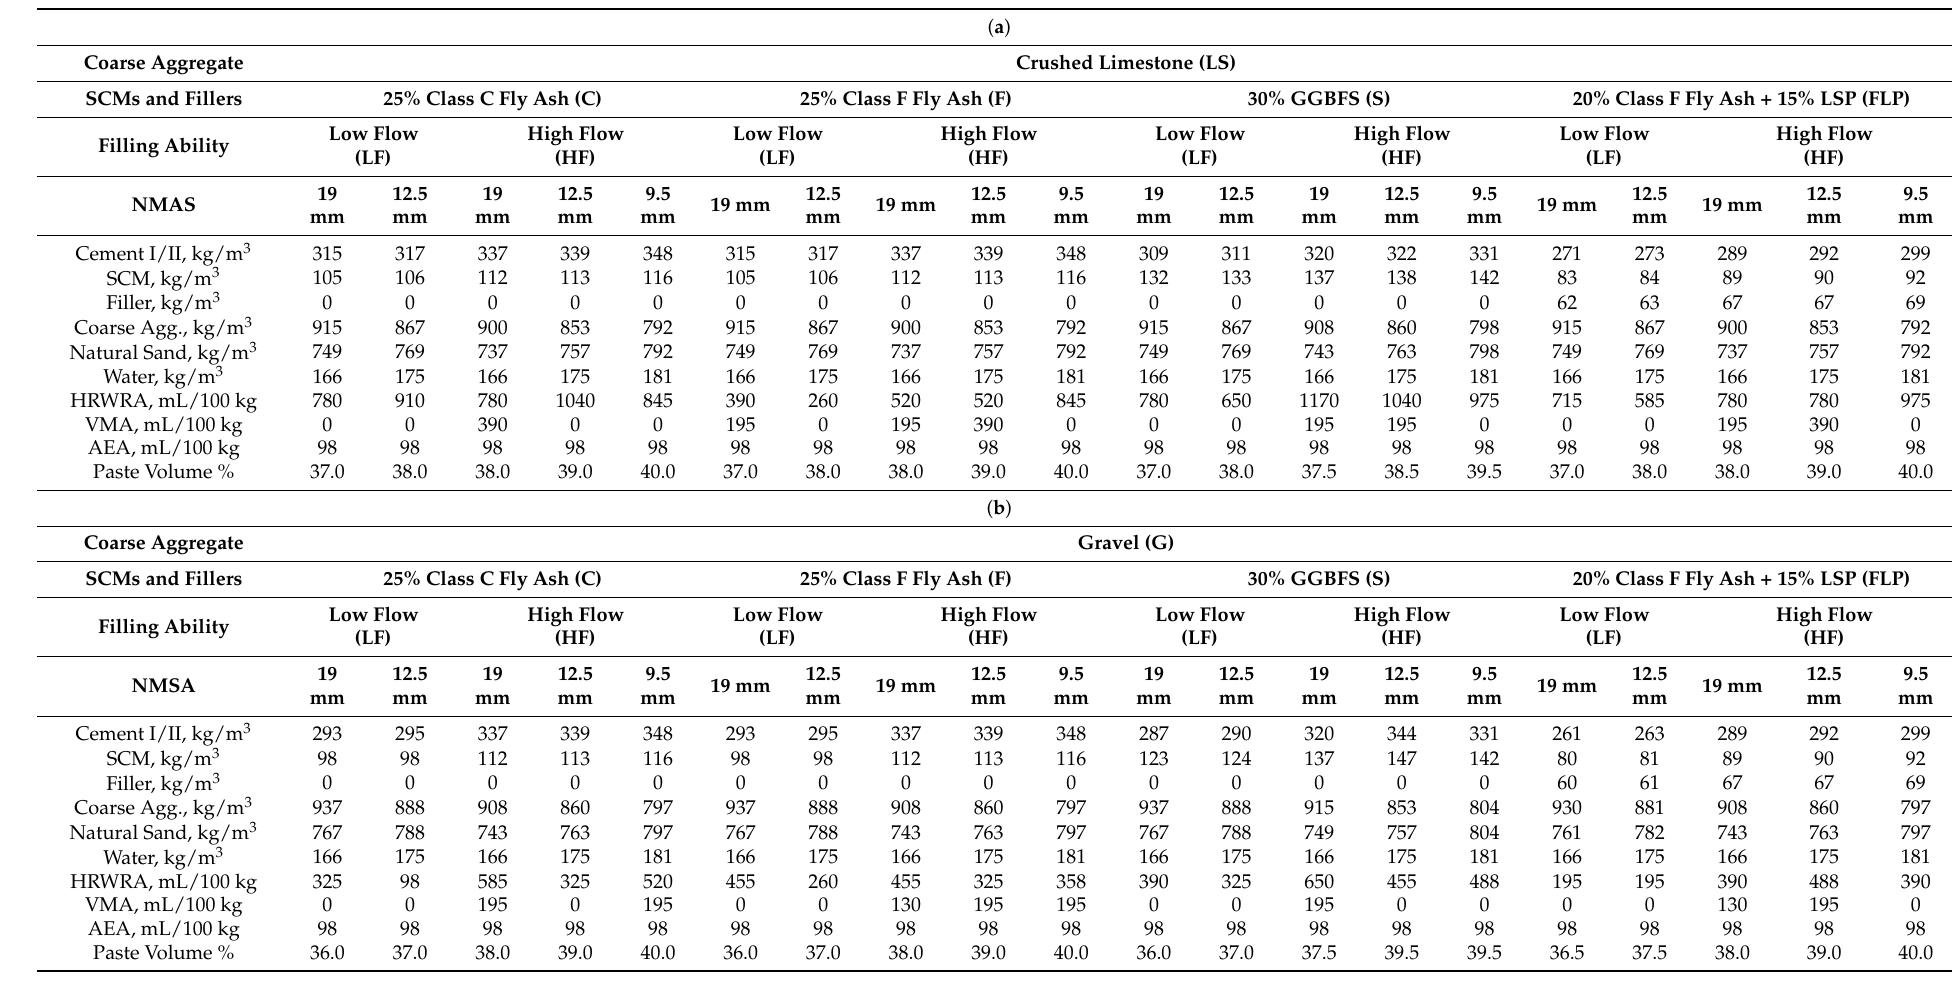
Table 4. ( a ) Proportions for SCC mixtures containing limestone aggregate (25 mm = 1 in.; 1000 kg/m 3 = 1686 lb/cy; 65 mL/100 kg = 1 oz/cwt). ( b ) Proportions for SCC mixtures